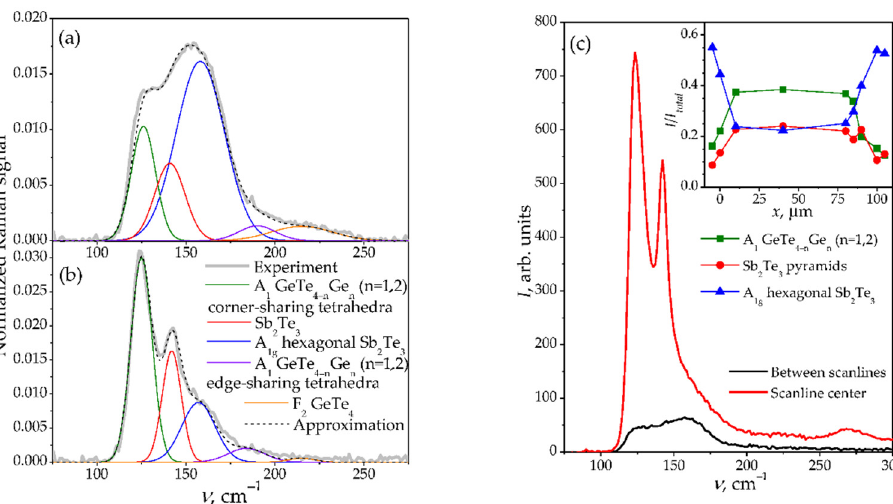
Figure 2. Raman spectra of as-deposited ( a ) and irradiated ( b ) GST225 samples, normalized by the integrated intensity of the whole spectra. Comparison of initial Raman spectra obtained between scanlines and at scanline center without normalization ( c ). The inset shows integrated intensities of Raman lines at 125 cm − 1 , 140 cm − 1 , and 158 cm − 1 along the scanline cross section, normalized by the integrated intensity of the whole spectra. The diameter of the probing Raman beam equals 5 μ m.